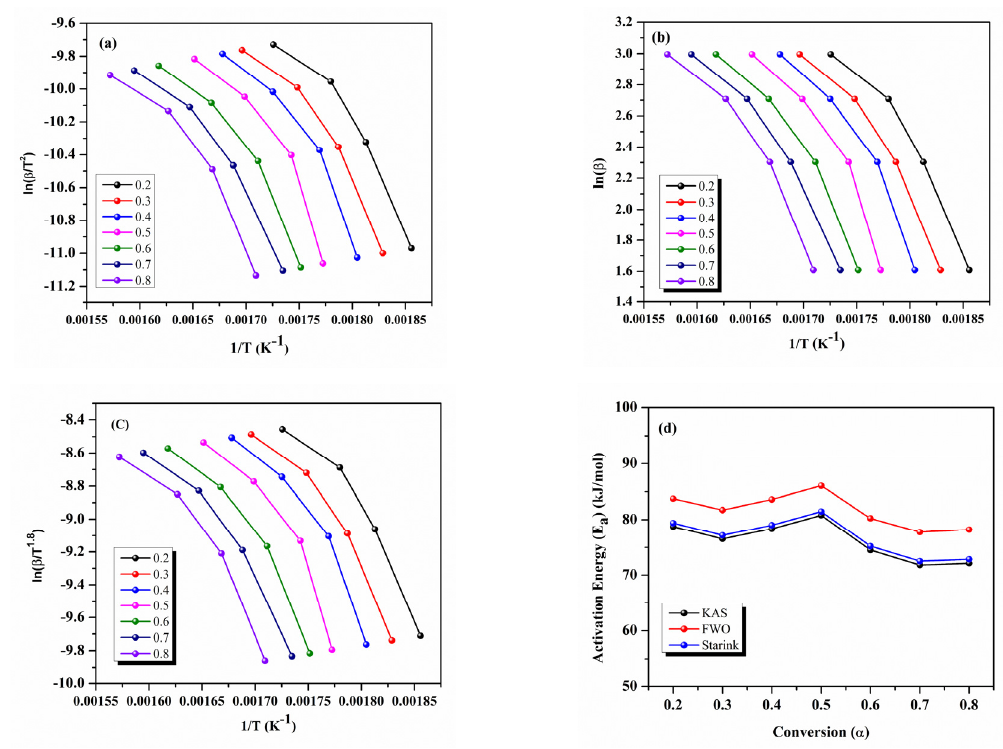
Figure 6. Pure PCM sample ( a ) ln β Activation energy with respect to various conversion.